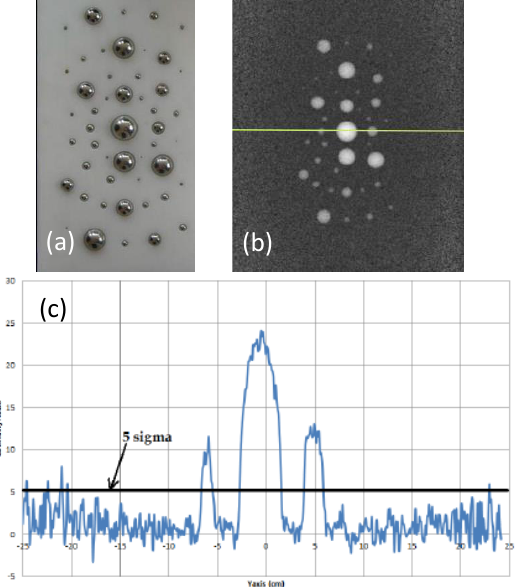
Fig. 6. Detection of metallic balls (reproduced with permission from Singh [12] ) including (a) the phantom embedded with steel balls, (b) a simulated X-ray image generated using MODHERATO and (c) the contrast to noise ratio along the analysis line in green in the top right image.